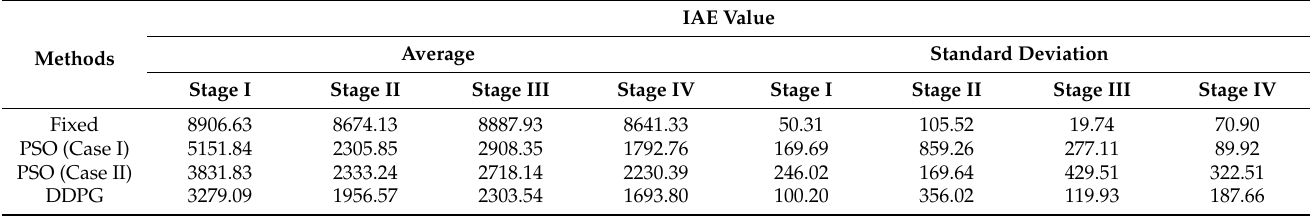
Table 7. IAE value of each